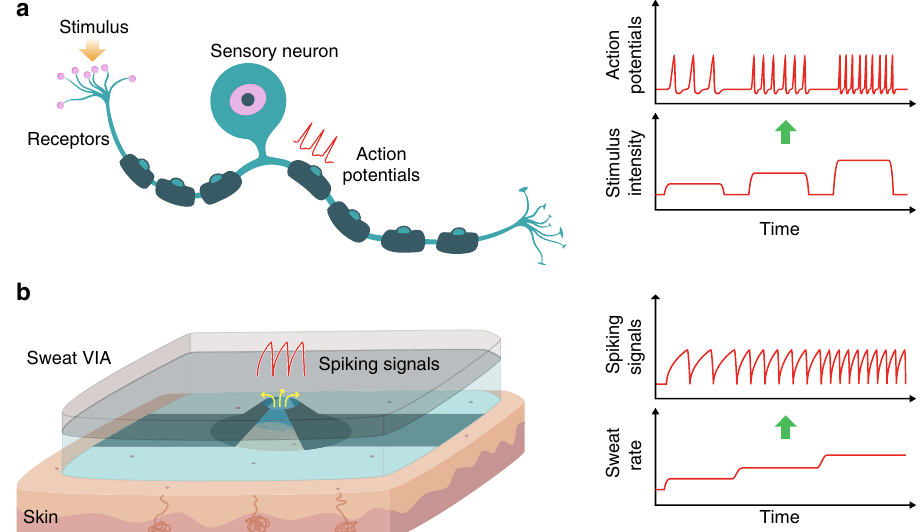
Fig. 1 | Schematic illustration of spike encoding of external stimuli of a biolo- gical sensory neuronand a sweat VIA sensor. a A biological sensory neuron that generates spike patterns upon receiving external stimuli through receptors with the spikefrequencyproportionaltothestimuliintensity. b AsweatVIAsensorthat